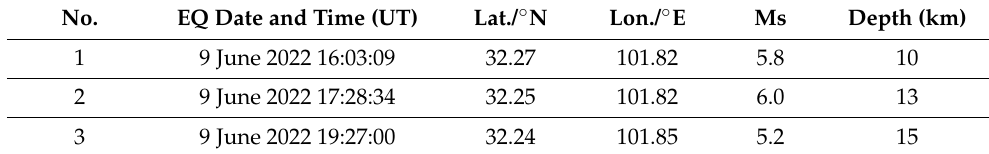
Table 1. Detailed earthquake